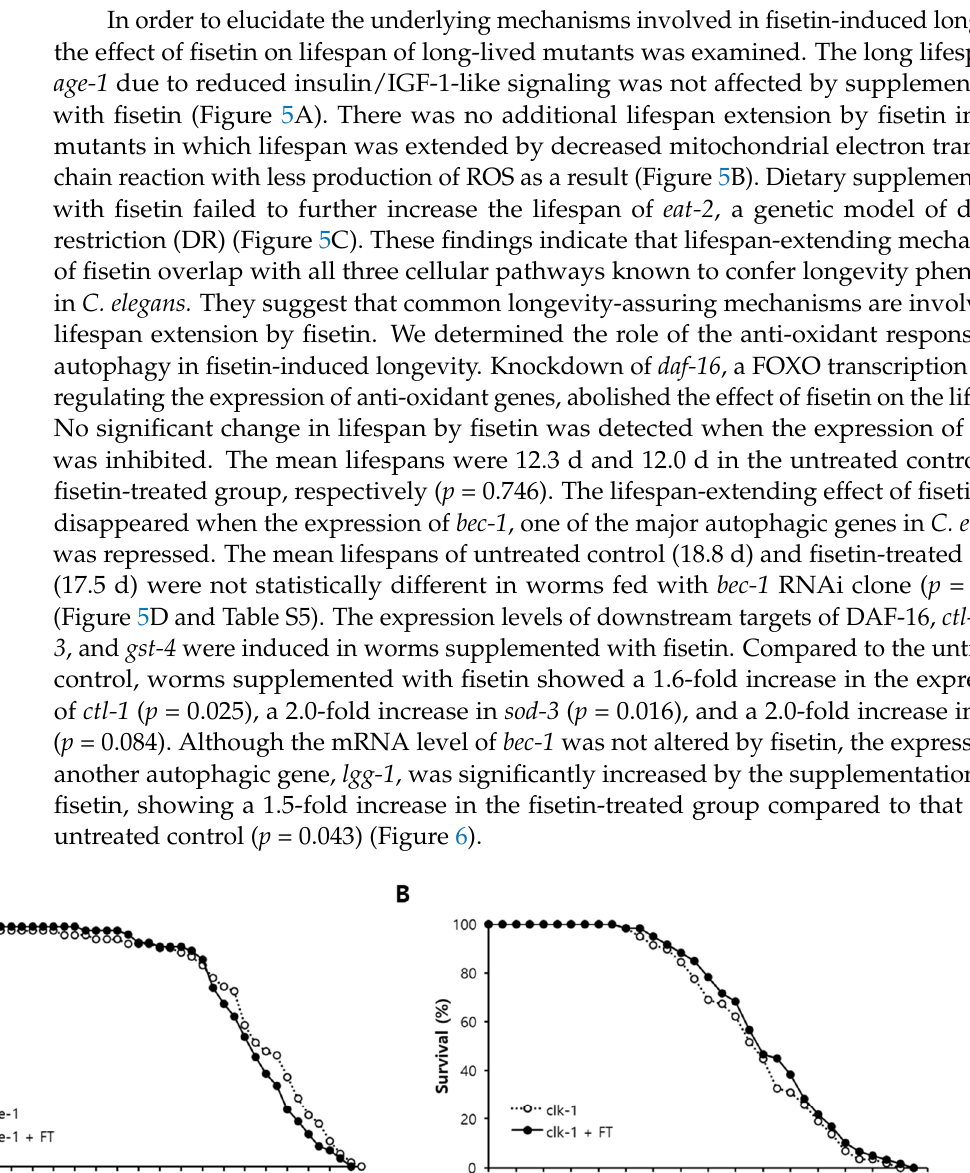
Figure 6. Quantitative RT-PCR of genes modulating anti-oxidant response and autophagy. Total RNA was extracted from 9-day-old worms and used for quantitative RT-PCR. Relative percent ex- pression of each gene in fisetin-treated worms was calculated comparing to the expression of the same gene in untreated control (100%). Error bar indicates standard error. *, p < 0.05 compared with control; FT, 0.1 g/L of fisetin.